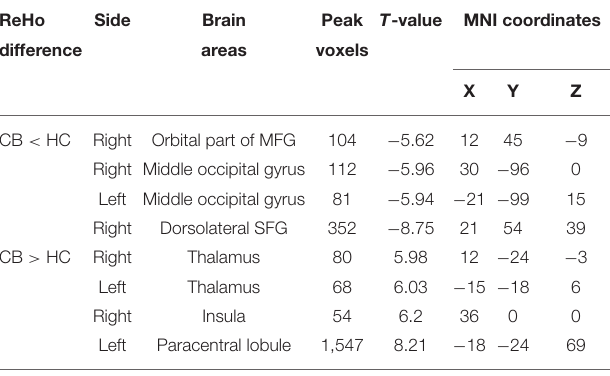
TABLE 3 | Brain areas with significantly different ReHo values between